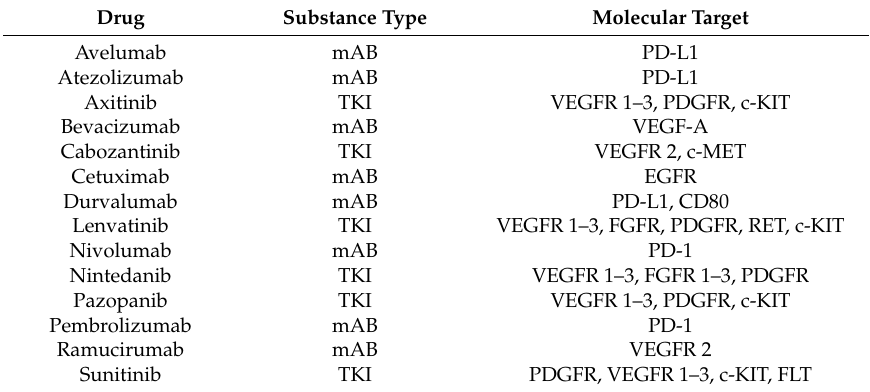
Table 1. Overview of target agents used as combination strategies in NSCLC and